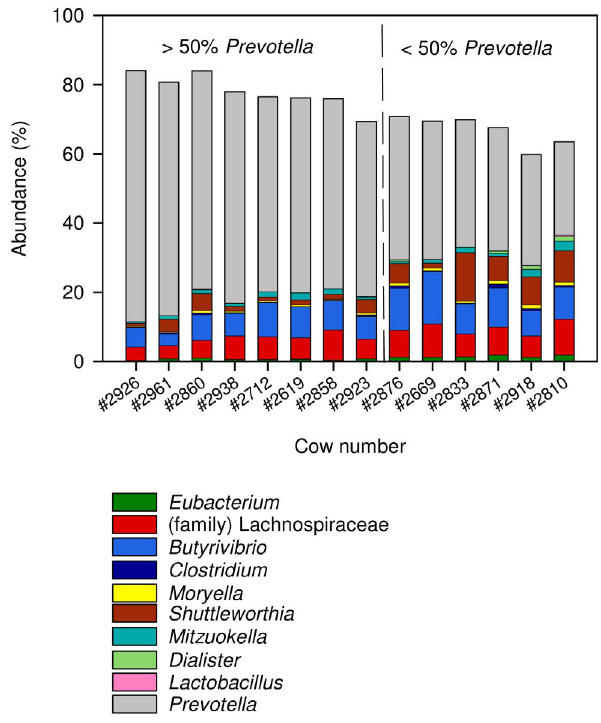
Figure 4. Abundance of genera within the phylum Firmicutes compared to the genus Prevotella . Stack bar showing the abundance of genera belonging to the phylum Firmicutes that were negatively correlated with Prevotella abundance. These included all genera that were in at least half of the cows sampled and constituted 0.1% of the reads in at least one cow. The gray portion of the bars represents the abundance of Prevotella (phylum Bacteroidetes). The dashed line separates samples with more than 50% Prevotella (left side) and from those with less than 50% Prevotella .